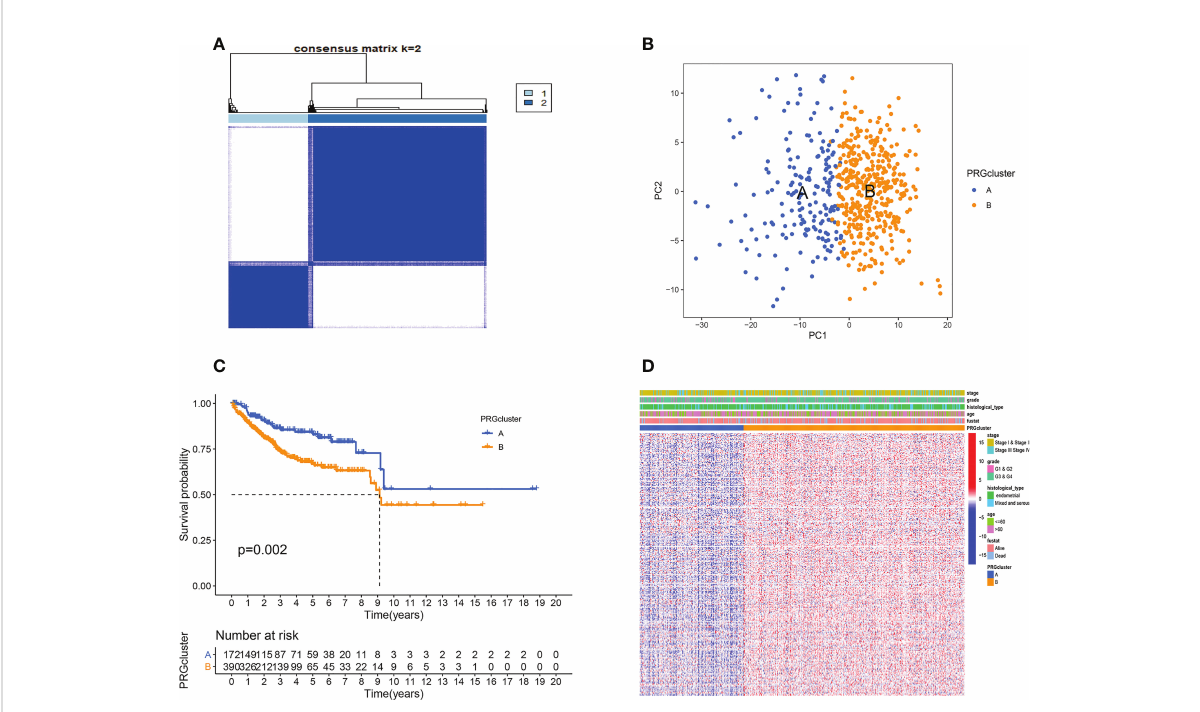
FIGURE 1 Cellular senescence subtypes and clinical assessment. (A) Two subtypes and their associated regions. (B) PCA analysis. There are signi fi cant differences between the two subtypes. (C) Survival analysis. Subtype B has a poorer prognosis. (D) There were no differences in clinical factors between the two